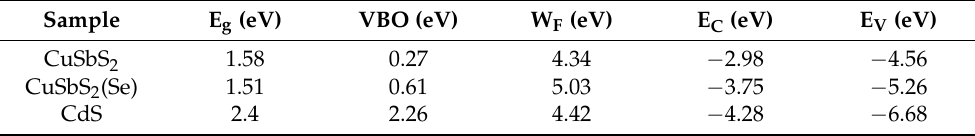
Figure 7. Optical properties and energy level analysis of CuSbS 2 and CuSbS 2 film: ( a ) UV–vis absorption spectra, ( b ) plots of ( α h ν ) 2 versus (h ν ); and UPS spectra of ( c ) CuSbS 2 (Se) selenized for 8 and 10 min and ( d ) CdS spectrum. Table 4. Parameters calculated from the UPS spectra.